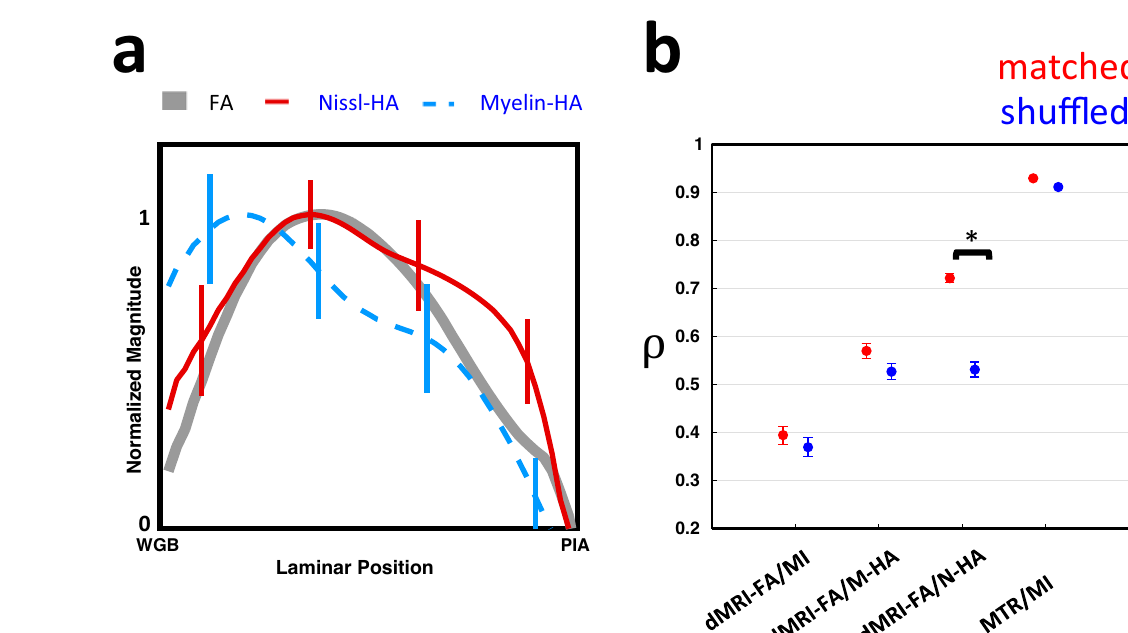
Bars indicate standard deviation. b The mean parcel correlation coef fi cients between MRIandhistologyvariablesfrommatchedlocations(seeFig.4),andwhenthecortical parcels of the histology parameters and those of the dMRI-FA are shuf fl ed between random horizontal locations. MI myelin intensity, N-HA Nissl-HA, M-HA myelin- HA. Bars indicate standard error. The star indicates signi fi cance under a two tailed paired t -test, p <10 − 10 . ρ indicates mean Pearson correlation coef fi cient. Each parcel is one of n =393 biologically independent samples from the marmoset cortex, spanning 18 distinct histological sections. Source data are provided as a source data fi